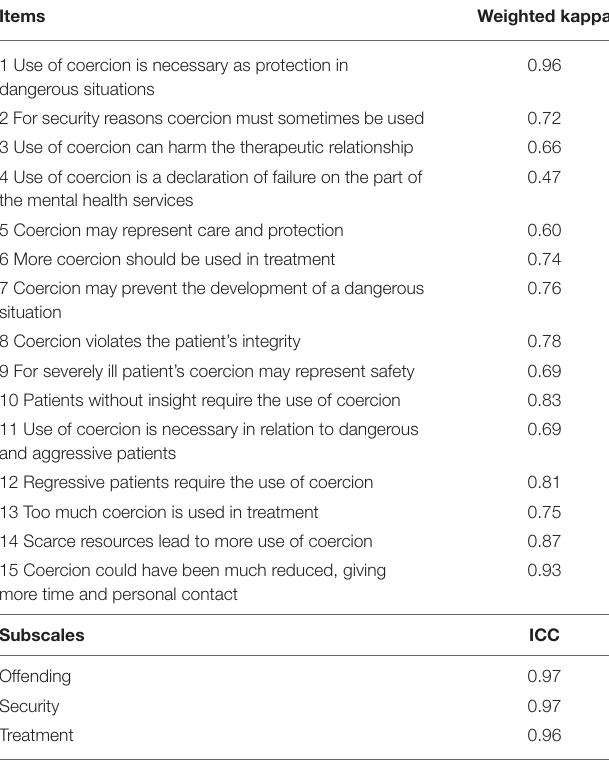
TABLE 3 | Reliability (test-retest) of items and subscales of staff attitudes to coercion scale ( N = 27).